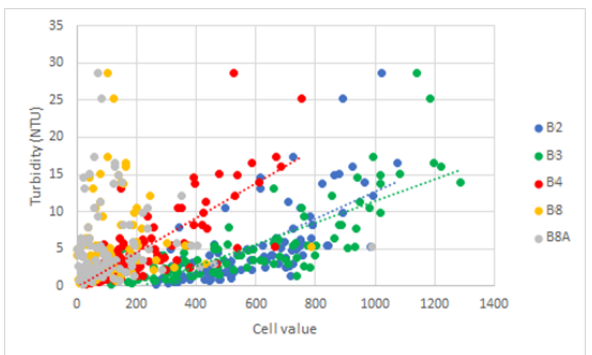
Figure 6. Scatter plot of the turbidity in situ measurements and the respective cell values of the considered bands.